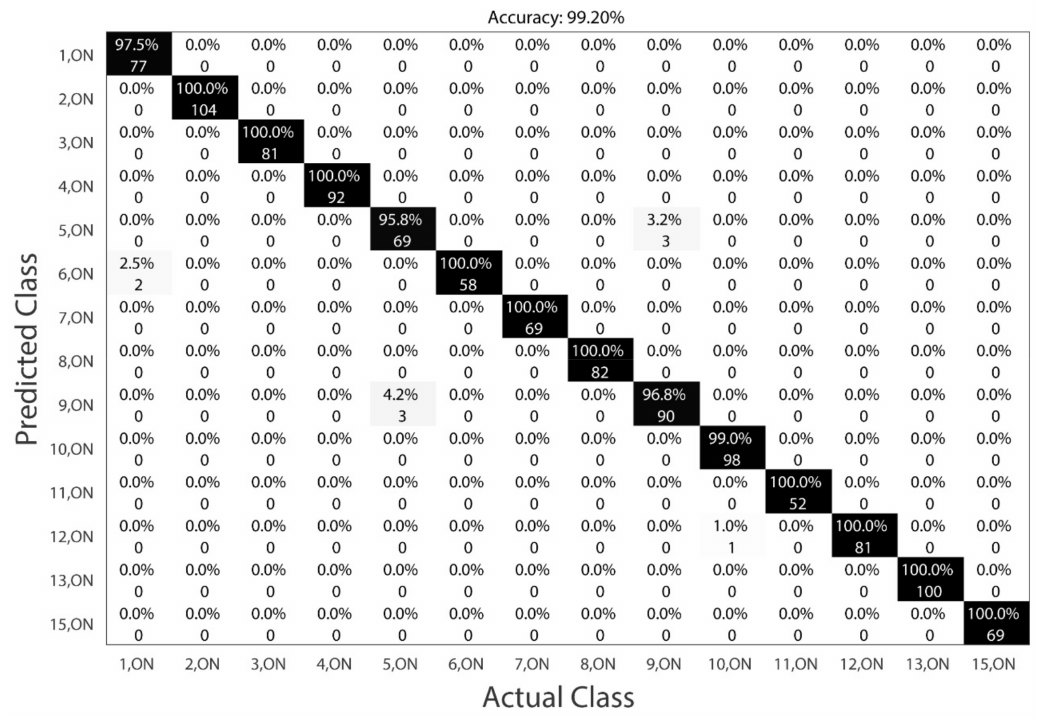
Figure 9. Confusion matrix for recognizing switch-on events of tested appliances using the dictio- nary